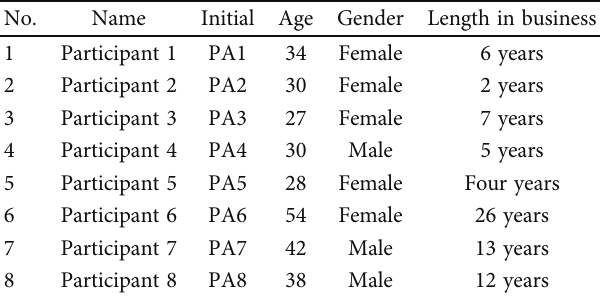
Table 2: Participant